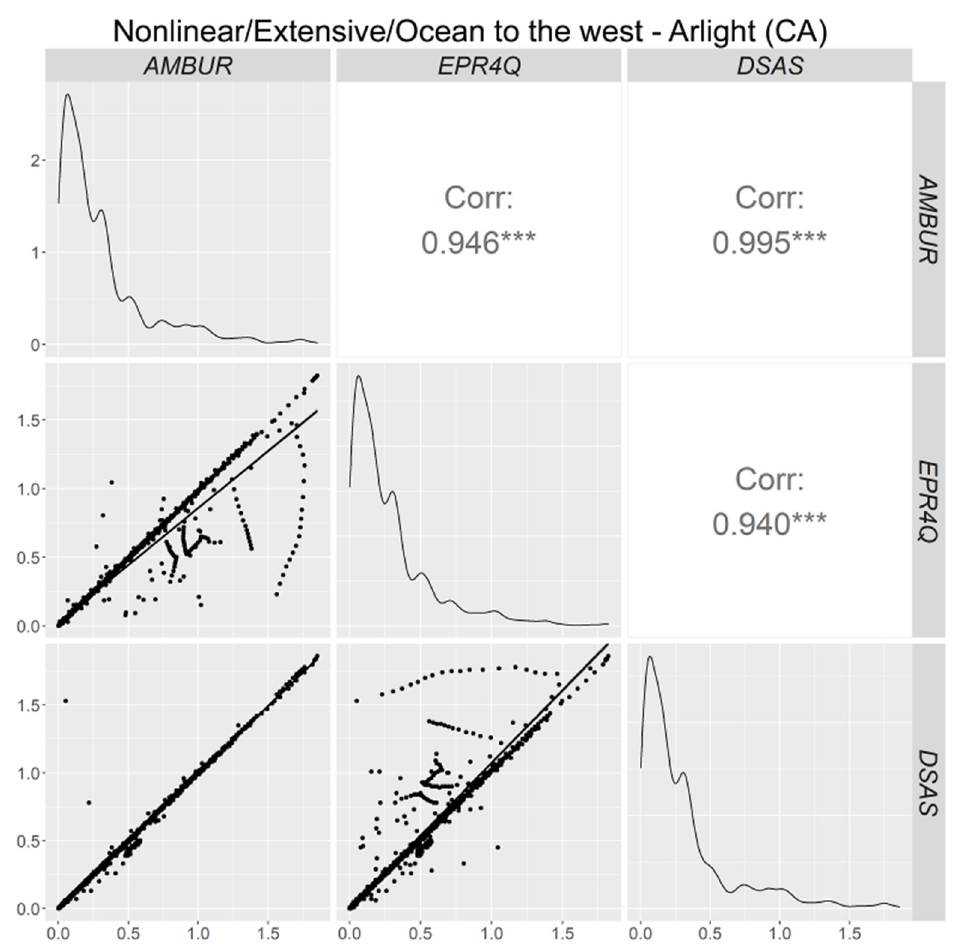
Figure 8. Matrix correlation of AMBUR, EPR4Q, and DSAS models on Indented/Extensive/Ocean to the west for Arlight coast. p -value significance symbols: “***”—0.001; “**”—0.01; “*”—0.05; “.”—0.1; No symbol—1. The matrix correlation shows the scatter plot between the models (EPR4Q × DSAS, EPR4Q × AMBUR, AMBUR × DSAS) on the left side. The frequency curve of the histogram of each model on diagonal and Pearson’s correlation is presented on the right.